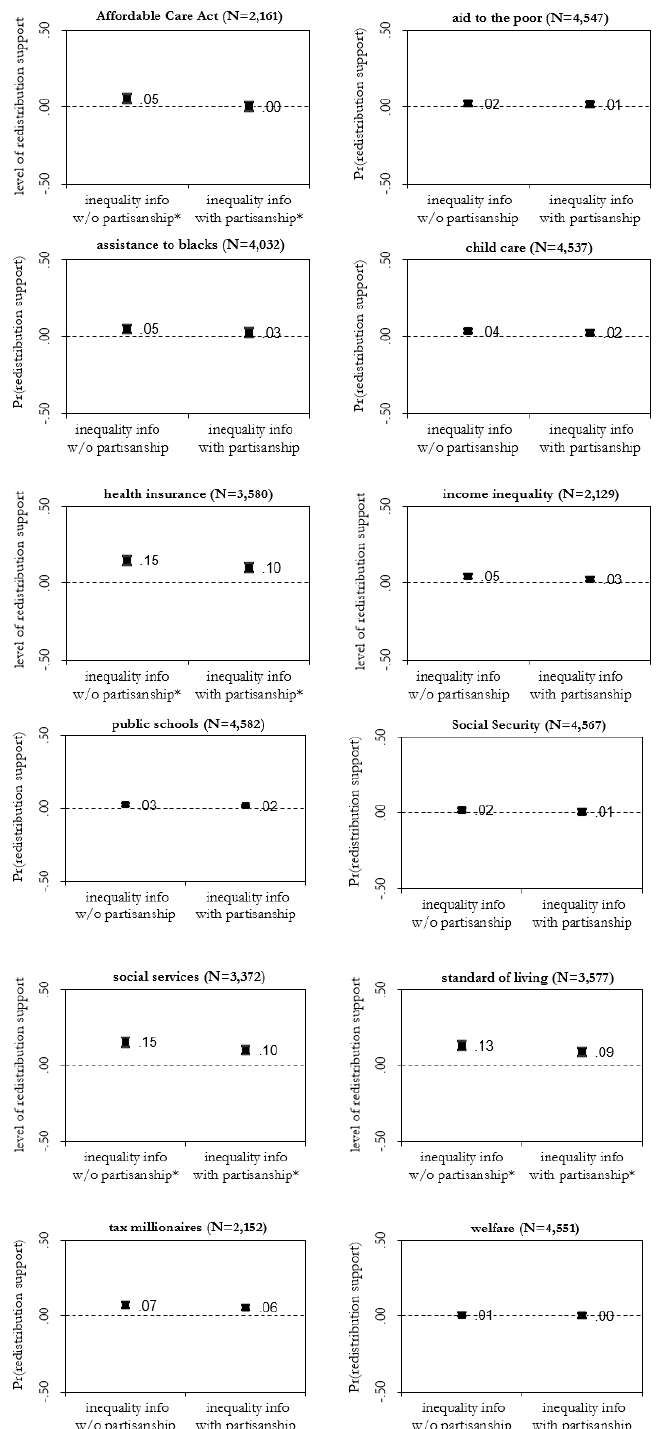
Figure 1. Average marginal effects of inequality information on redistribution preferences (without versus with partisanship), American National Election Studies 2004–2016. Estimates are average predicted change in standardized level/probability of redistribution support due to a one standard unit increase in inequality information (95% confidence intervals indicated by bars). An asterisk indicates that estimates without versus with partisanship controlled differ ( p < 0.05).